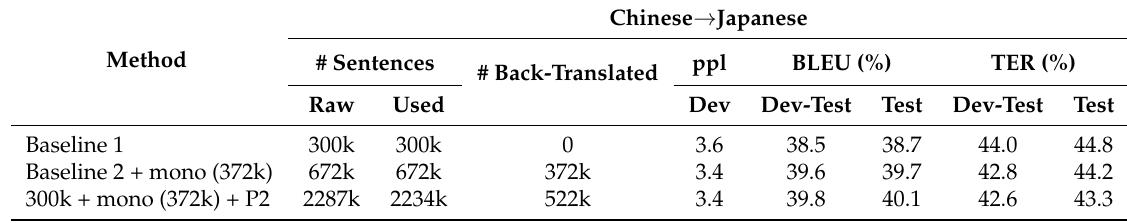
Table 8. Experiment results of Japanese → Chinese MT with 300k sentences and 372k monolingual sentences. “ppl” denotes perplexity. “Dev” denotes development data. “Dev-test” denotes development-test data.